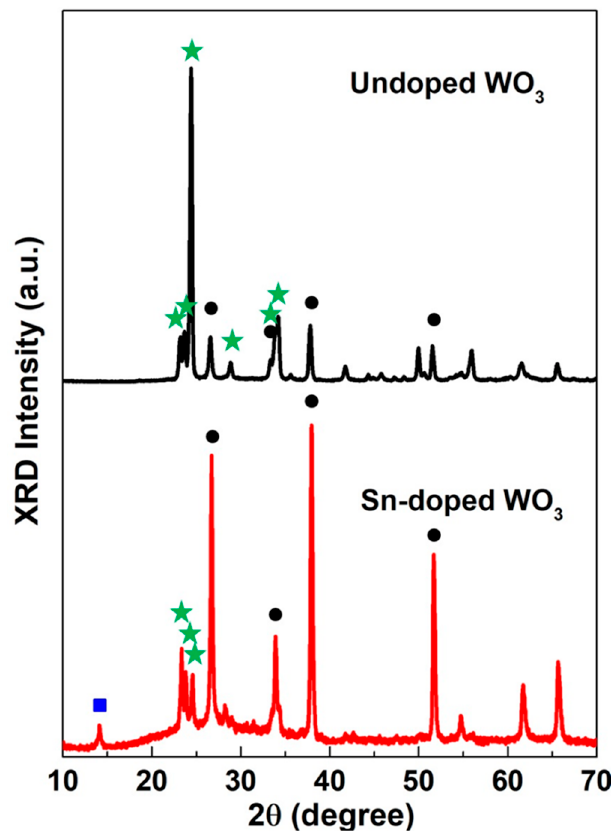
Figure 2. XRD patterns of undoped and Sn-doped WO 3 thin films. The XRD peaks of FTO substrate and monoclinic and hexagonal WO 3 are indicated by a dot (black), star (green) and square (blue) marks.